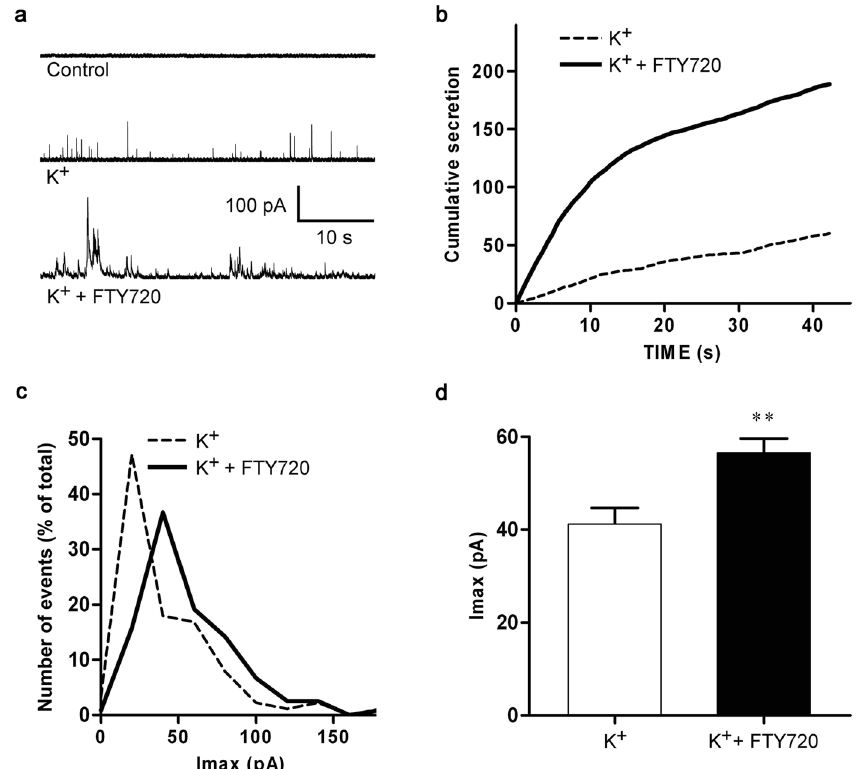
(K + ) when pre-incubated or not with a 20 µ M FTY720 solution for 15 min. ( b ) A graph showing the cumulative secretion obtained by integration of amperometric responses from control (n = 89) and FTY720-treated cells (n = 129). Averaged individual spikes in the form of amplitude distributions ( c ) and the mean amplitude ± SEM ( d ) demonstrate the effect of FTY720 on individual secretory events ( ** P < 0.005, Student’s